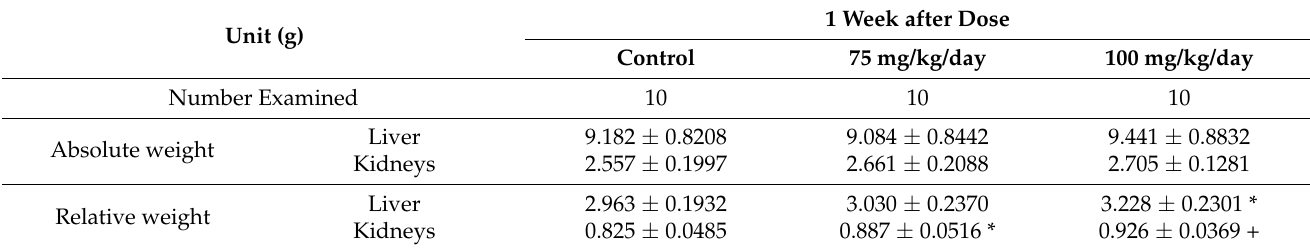
Table 2. Absolute and relative organ weights obtained from 1-week consecutive ifosfamide-administered rats. 1 Week after Dose Unit (g) Control 75 mg/kg/day 100 mg/kg/day Number Examined